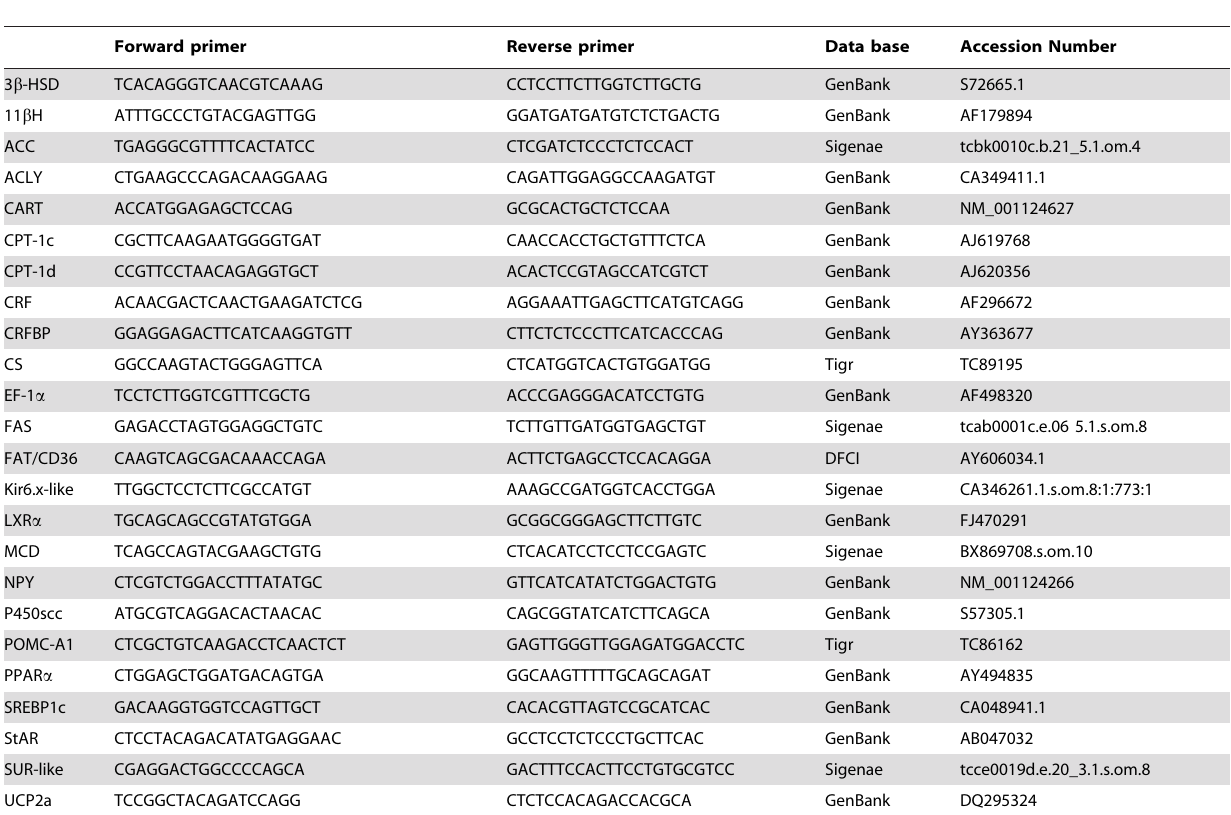
Table 1. Nucleotide sequences of the PCR primers used to evaluate mRNA abundance by RT-PCR (qPCR).